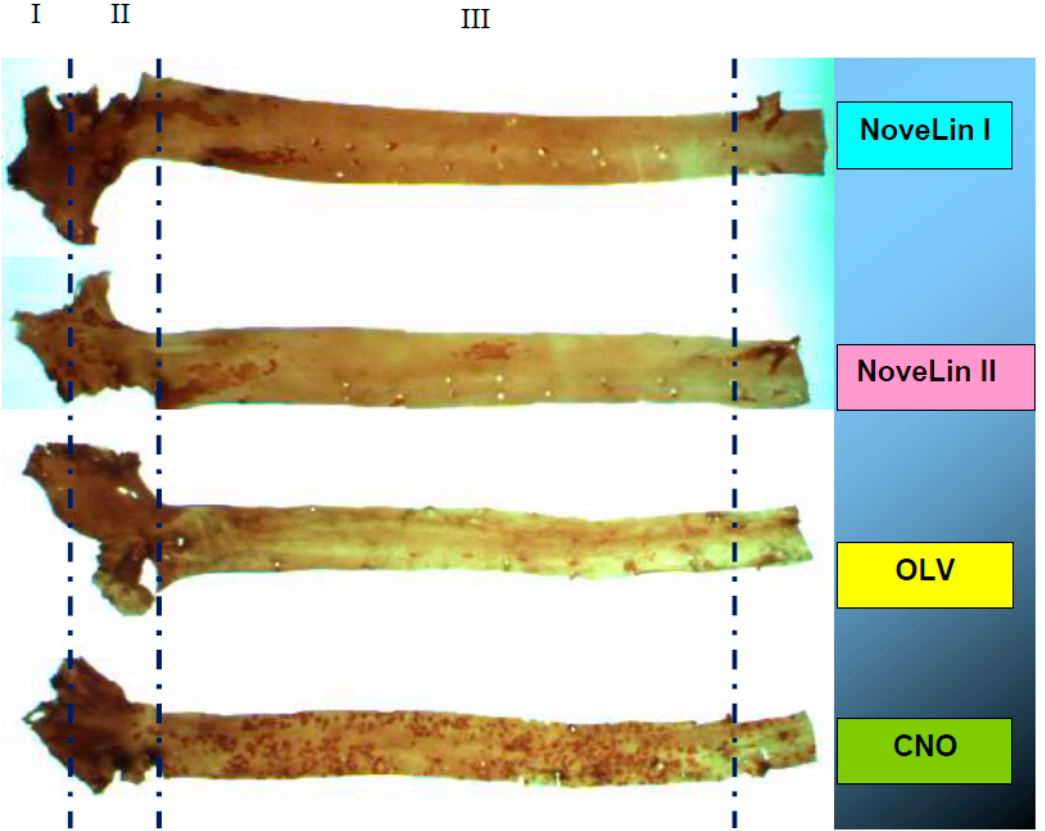
Figure 1. Photographs of aortic lesions in rabbits fed an intervention diet. CNO: Coconut Oil; OLV: Olive Oil. Atherosclerosis development is shown as (I) fibrous plaques, (II) fatty plaques, and (III) fatty